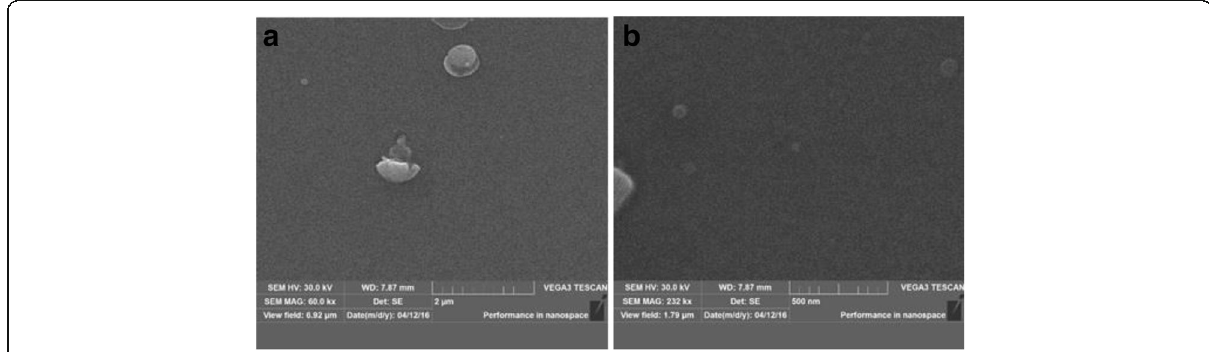
Fig. 1 The surface morphology of ZnO/silicon samples deposited at the different substate temperatures T s : a 200 °C; b 300